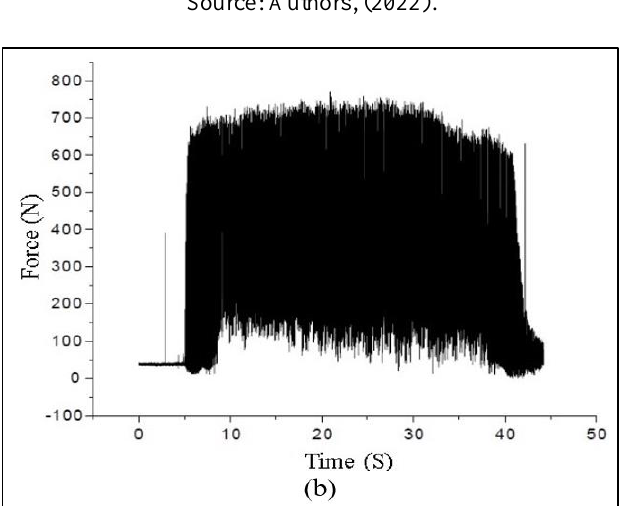
Figure 14a: Sample with sealant (nose radius 0,4 mm): (a) Machined surfaces. Source: Authors, (2022).